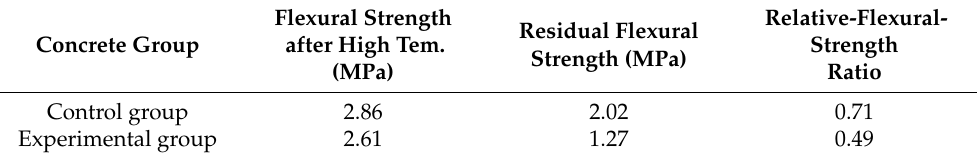
Table 25. Relative-flexural-strength ratios of the flexural failure specimens exposed to high tempera- ture after self-healing.